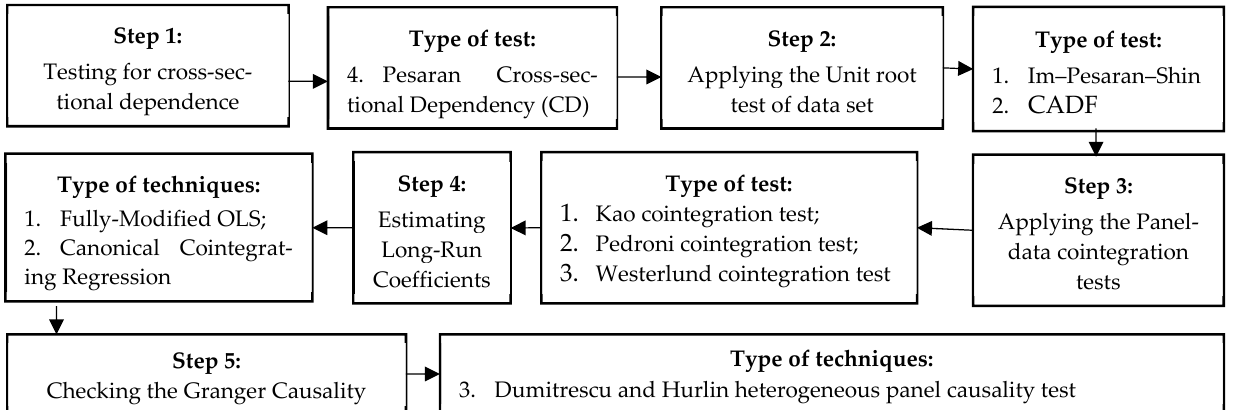
Figure 1. The main stages of the research and relevant methods, tests, and techniques.